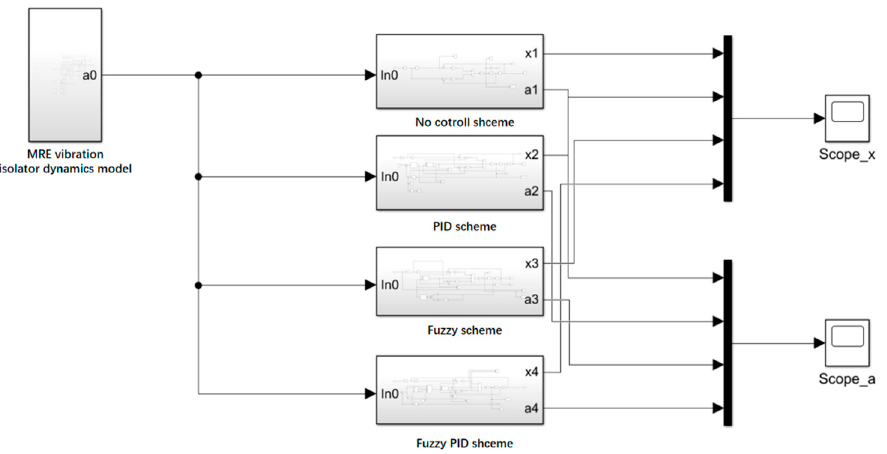
Figure 15. Block diagram of the MRE vibration isolation control system.